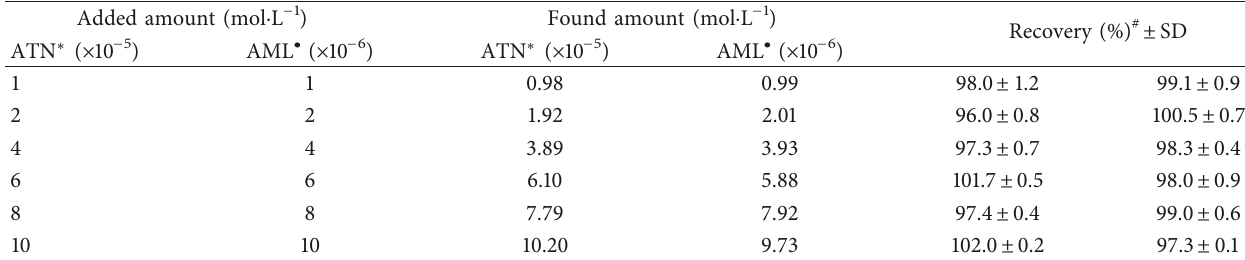
Table 5: Determination of ATN and AML in the pharmaceutical dosage form and in spiked urine sample. Product